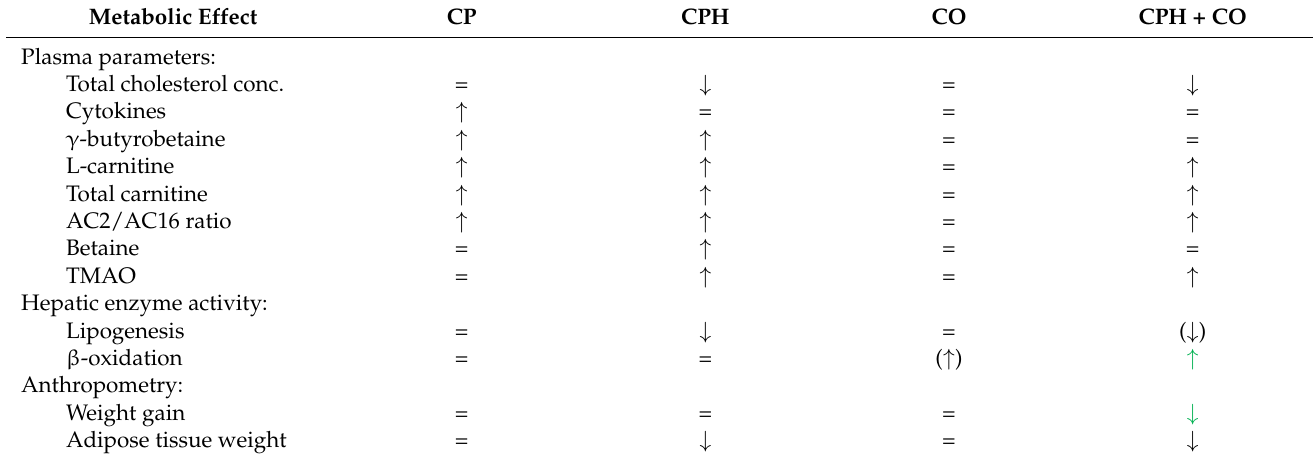
1 Arrows indicate direction of change compared to a casein and lard control diet. Green arrows indicate an additive effect of CPH and